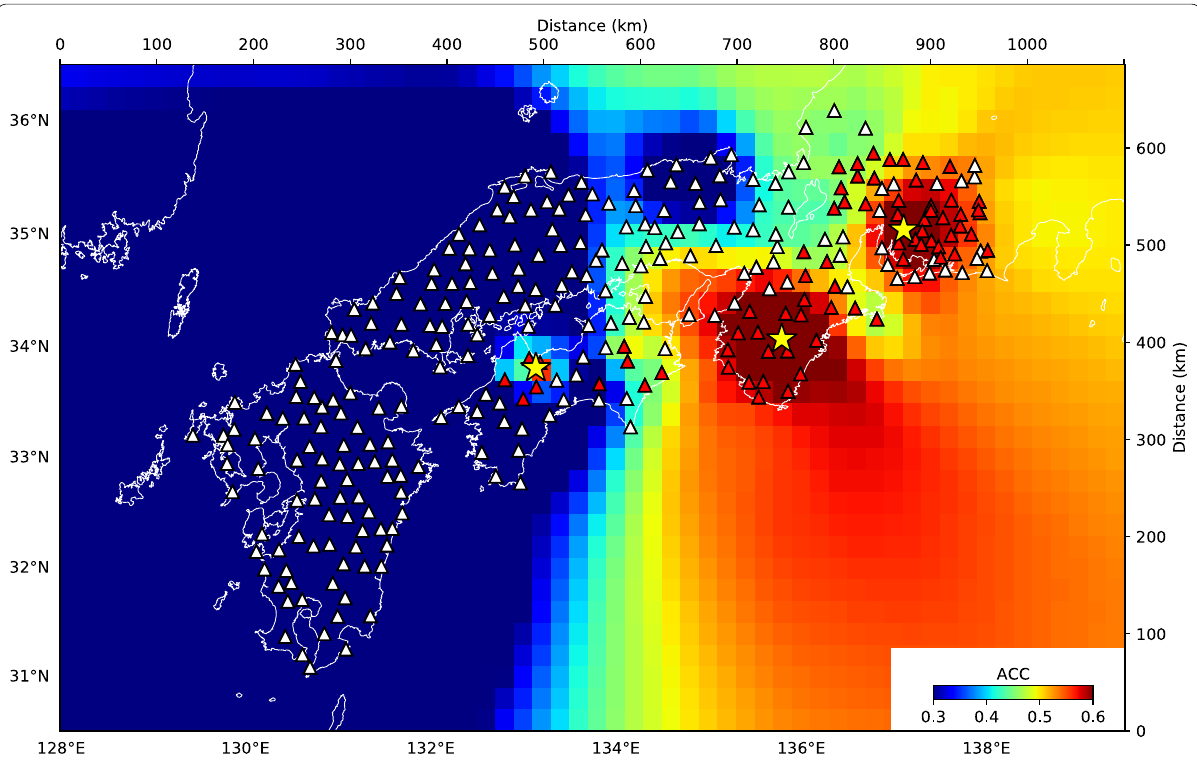
Fig. 4 Location results for three tremors that occurred between 00:12:30 and 00:17:30 on November 15, 2010. The three tremor epicenters are located at the local maxima of the ACC distribution. The western tremor occurred at 00:14:14, with a hypocentral location of 33.818°N, 133.138°E, and 27.4 km depth. The middle tremor occurred at 00:15:08, with a hypocentral location of 34.077°N, 135.794°E, and 34.8 km depth. The eastern tremor occurred at 00:16:22, with a hypocentral location of 35.049°N, 137.111°E, and 35.6 km